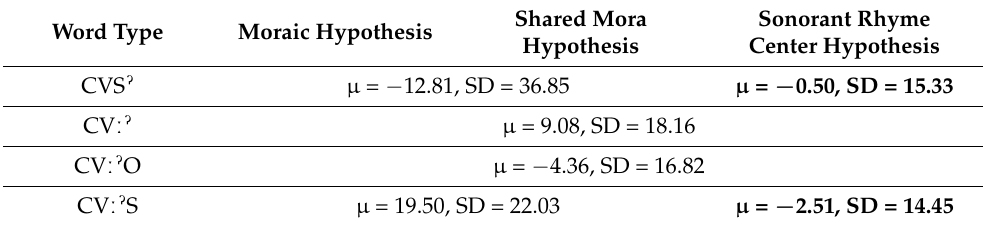
Table 9. Means and SDs for measures of stød onset timing by hypothesis and word type, as a percentage of the relevant phonological domain. For